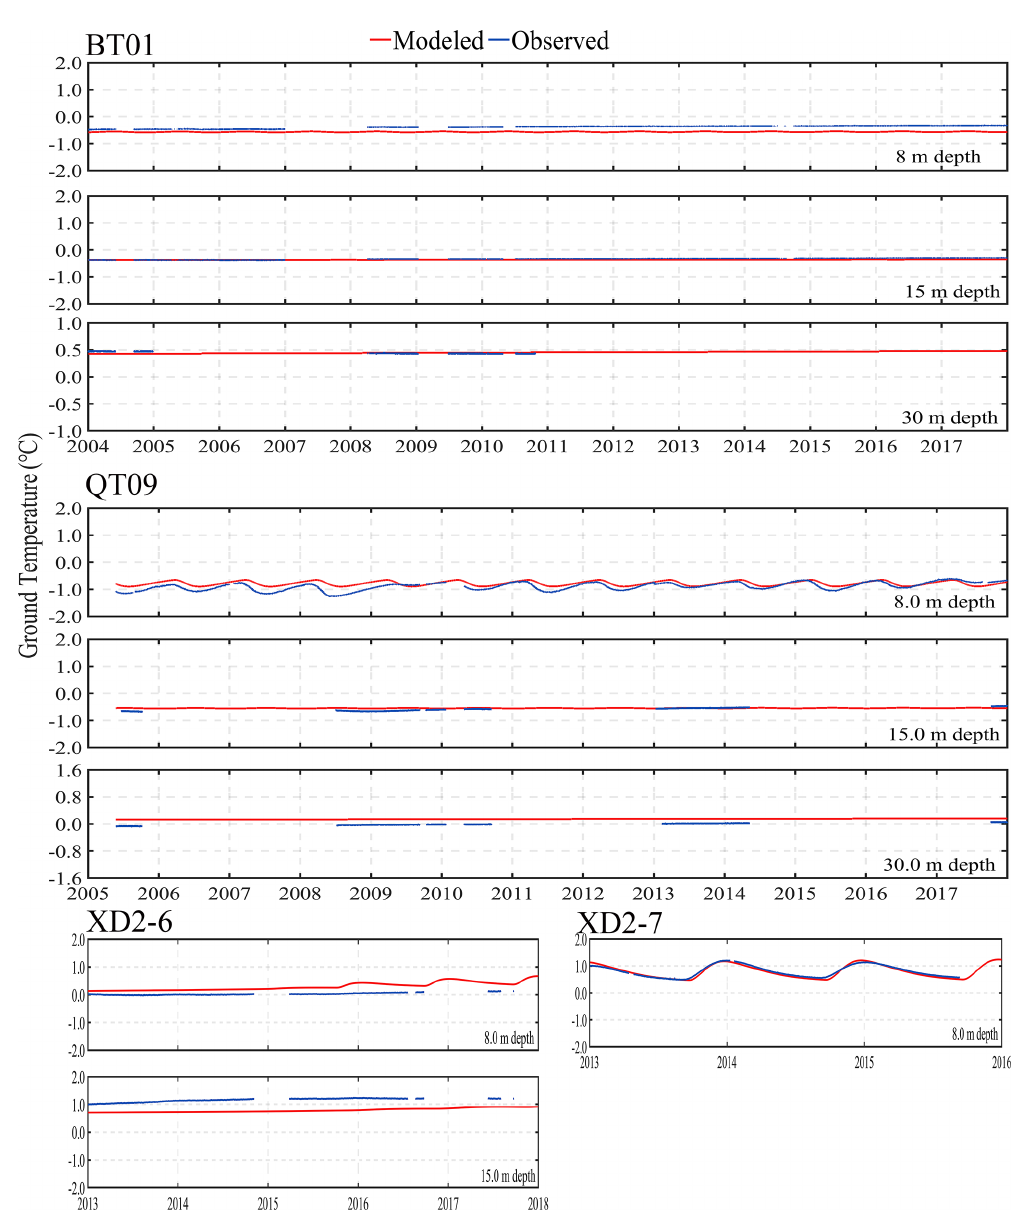
Figure A2. Same as Fig. 2 but for the daily mean ground temperature at 8, 15, and 30m.